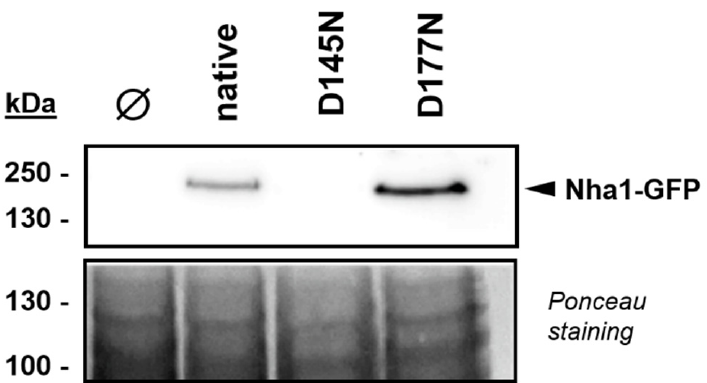
Figure A2. Immunodetection of Nha1-GFP versions. Extracts from BW31 cells expressing Nha1-GFP versions from multicopy plasmids growing in YNB plus 2% glucose were prepared as indicated in Material and Methods, subjected to SDS–PAGE (10% gel), and transferred to a nitrocellulose membrane. The Nha1-GFP was detected with a monoclonal anti-GFP antibody. The membrane was stained with Ponceau red to monitor loading and transfer